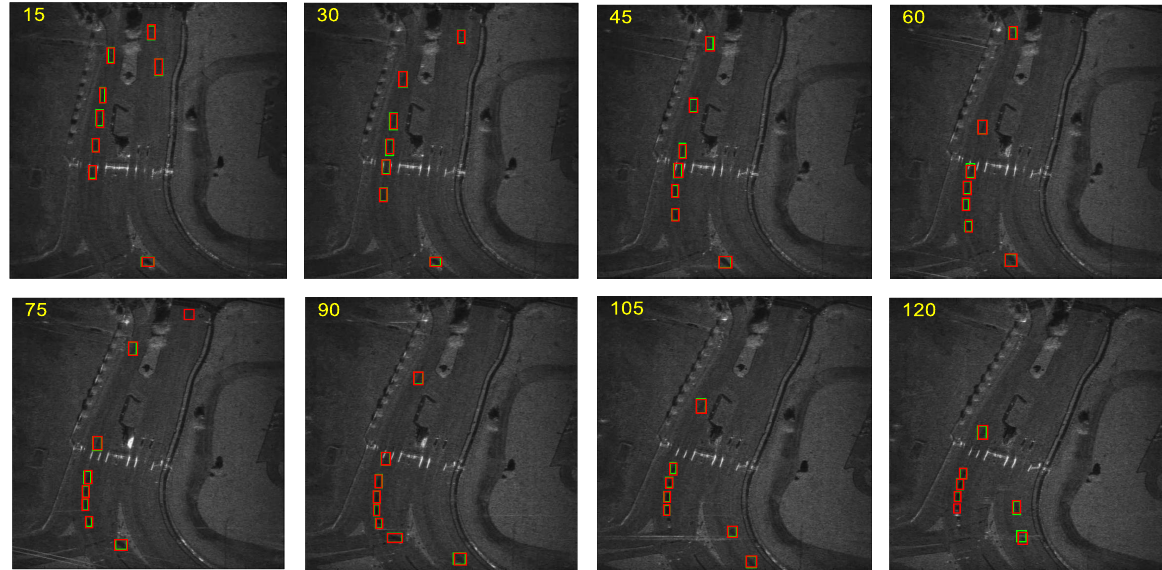
Figure 20. The detection results of eight frame images in the second test set. The green boxes denote the ground truths of the moving targets and the red boxes mean the detection